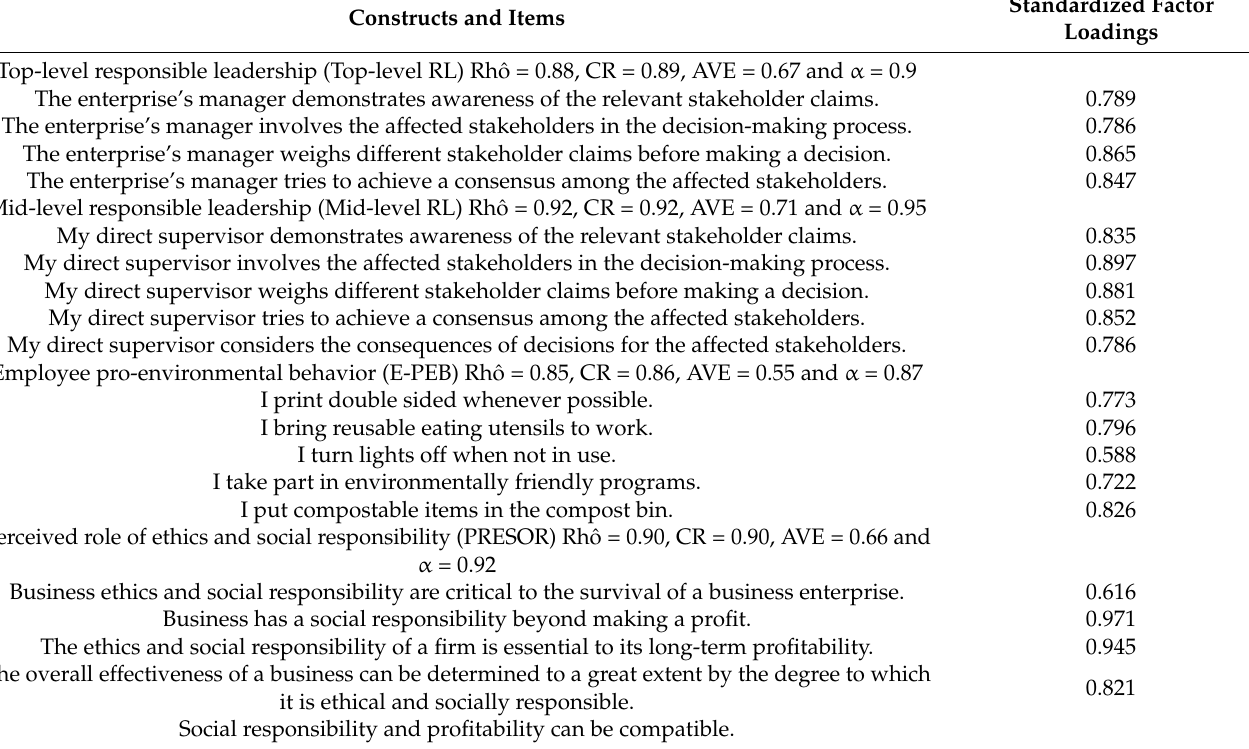
Table A1. Measurement model